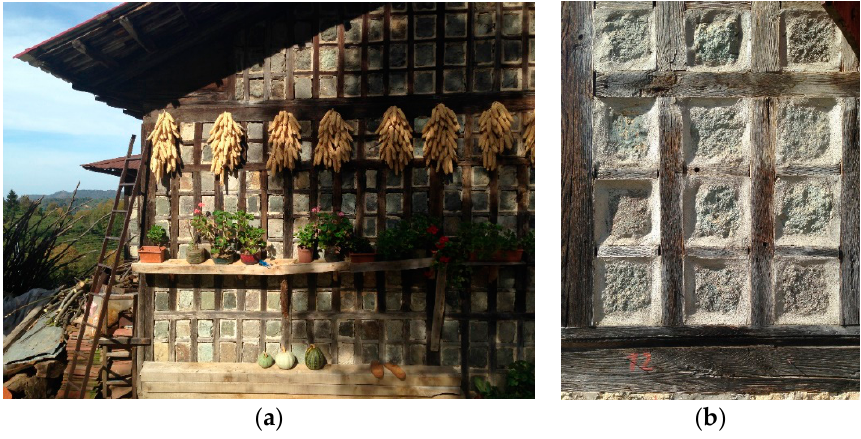
Figure 5. (a) Wooden facade with stone as filling material (Photographed by Ömer Faruk Bayram); (b) Relation of wood and stone in detail (Photographed by Ömer Faruk Bayram).